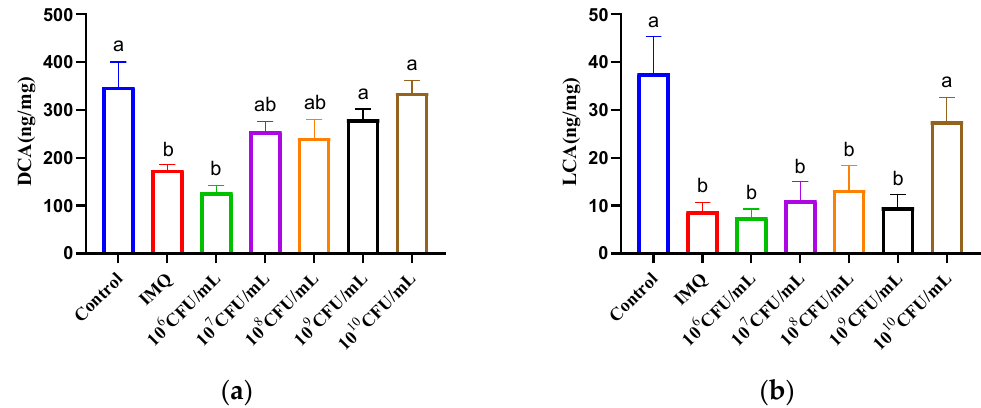
Figure 5. Effect of CCFM683 treatment on colonic bile acids in psoriasis mice. ( a ) DCA and ( b ) LCA in the colon. n = 8 mice per group. Groups with different letters are significantly ( p < 0.05) different from each other.